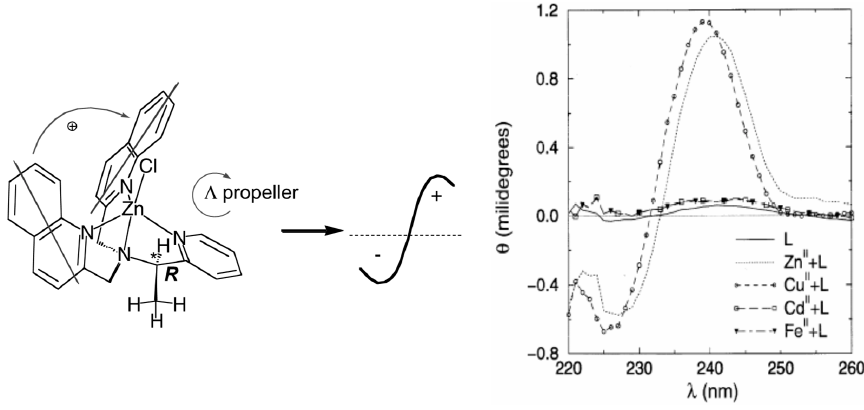
Figure 13. Circular dichroism spectra of ( R )-MeBQPA and complexes with Zn(ClO 4 ) 2 , Cd(NO 3 ) 2 , Cu(ClO 4 ) 2 , and FeCl 2 in aqueous 4-(2-hydroxyethyl)-1-pieperazineethanesulfonic acid (HEPES) buffer. Adapted with permission from Reference [46]. Copyright (1998) the Royal Society of Chemistry.